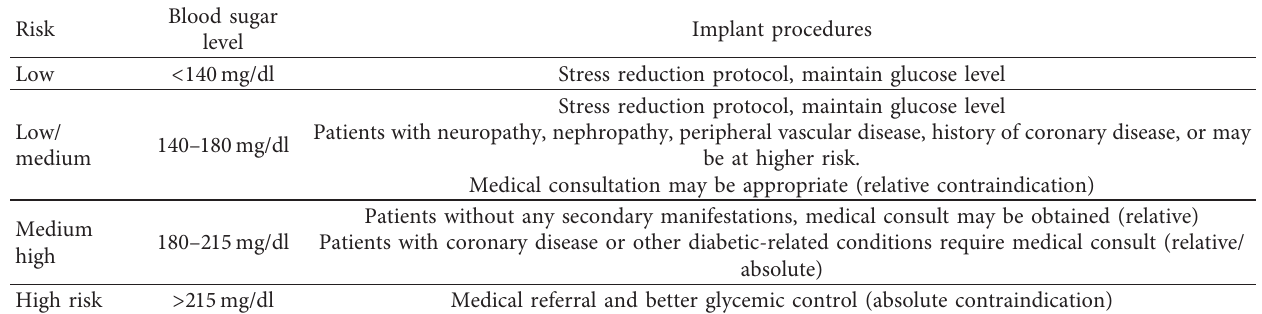
Table 6: Implant procedure plan according to postprandial blood glucose level